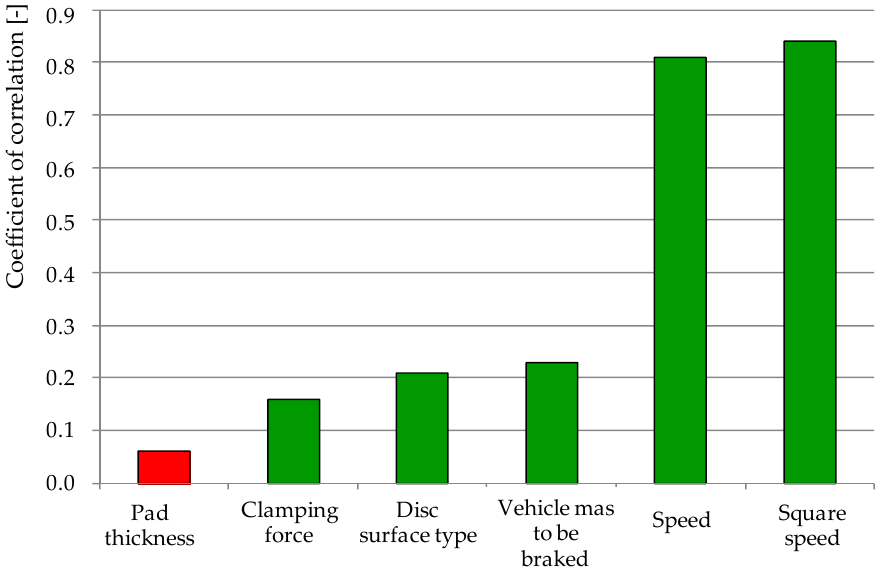
Figure 8. Distribution of the correlation coefficients of the variables of the friction pad weight wear model, green means that as the value of the variable increases, the wear of the pads increases, and red means that as the value of the variable increases, the wear decreases.